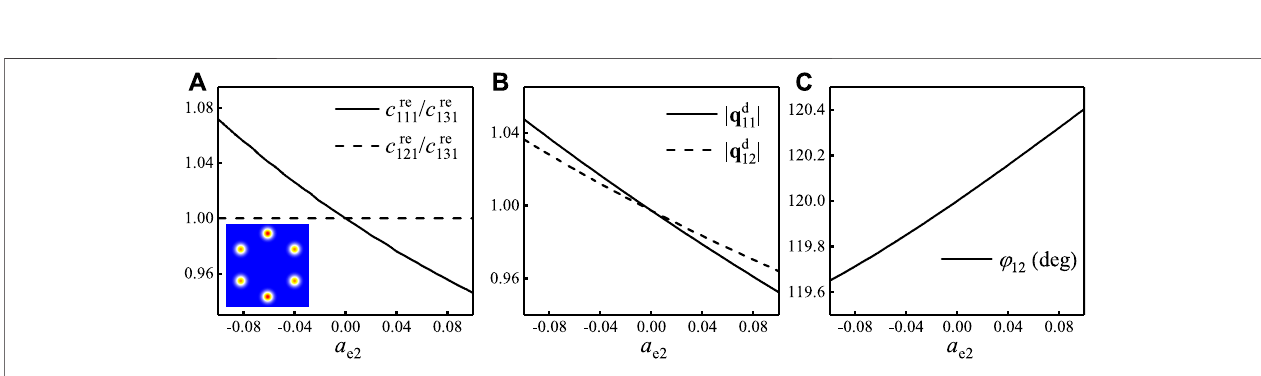
FIGURE3| DeformationofSkXinducedby a e2 . (A) therelativewaveamplitudes c re 111 / c re 131 and c re 121 / c re 131 , (B) thewavelengths between q d 11 and q d 12 as functions of a e2 . The results are calculated at b (cid:2) 0 . 2 and t (cid:2) 0 . 5. The inset in (a) shows the fi rst-order Bragg spots at a e2 (cid:2) − 0 . 1.